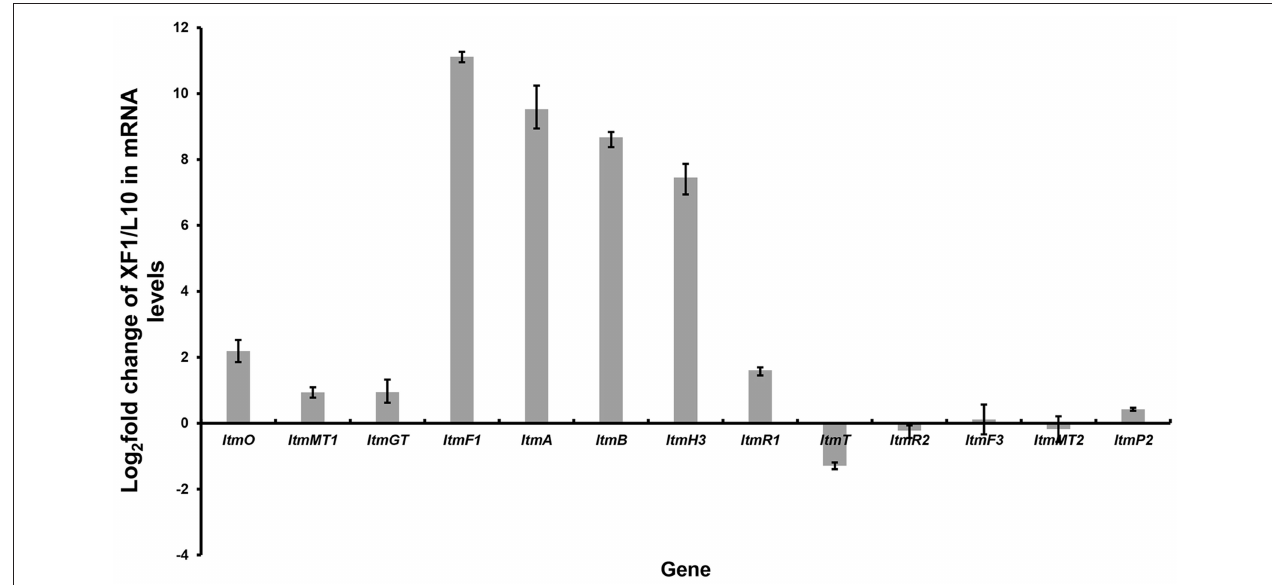
FIGURE 3 | Quantitative real-time PCR experiment. By promoter replacement, gene transcription levels from ltmF1 to ltmH3 in S. chattanoogensis XF1 were significantly upregulated, while genes distributed at two sides were almost the same transcriptional levels as the control strain L10. Fold change was indicated as log 2 (XF1/L10).